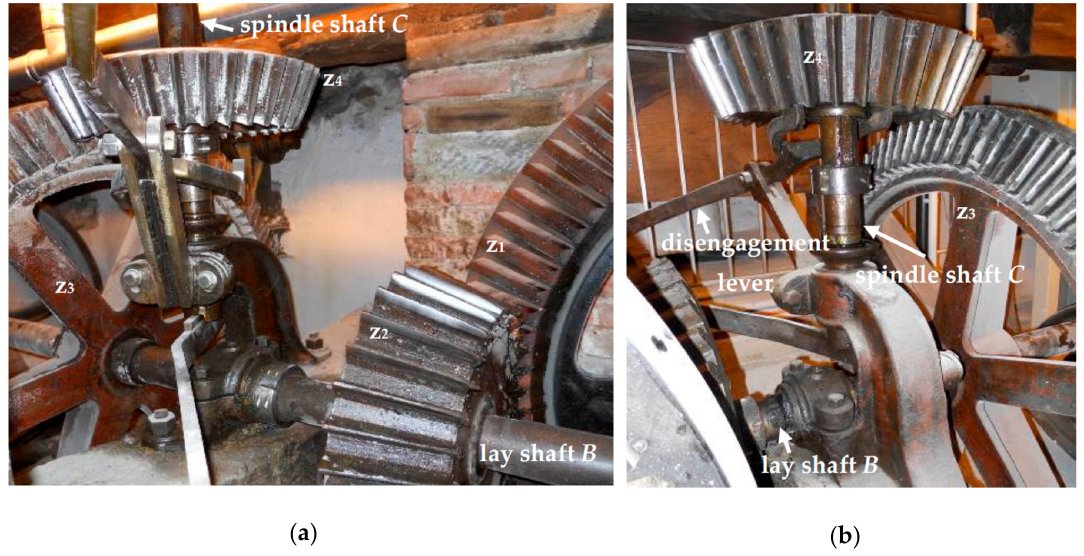
Figure 9. The Riviera mill power transmission: (a) Engagement of the runner stone; (b) disengagement of the runner stone.